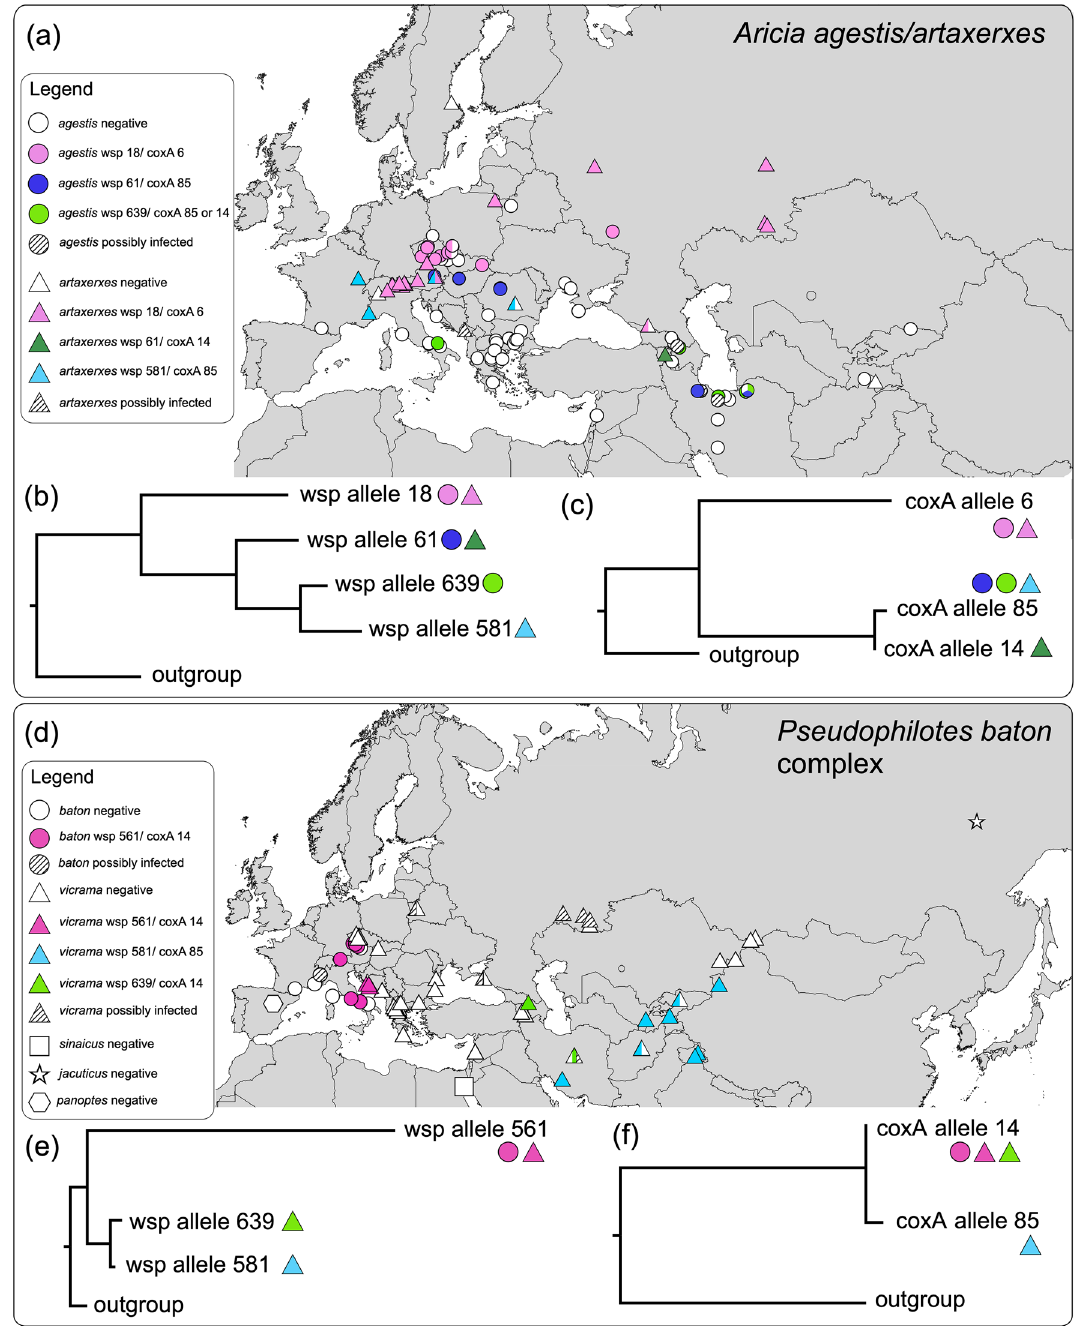
Figure 3. Wolbachia infection in two groups of closely related lycaenid butterflies: ( a – c ) Aricia agestis / A. artaxerxes : ( a ) distribution map, ( b ) Bayesian phylogenetic tree (MrBayes) of wsp, and ( c ) of coxA alleles. d–f Pseudophilotes baton species complex, ( d ) distribution map, ( e ) Bayesian phylogenetic tree of wsp, and ( f ) of coxA alleles. For a part of the samples, only the wsp gene was obtained, such samples were categorized by their wsp alleles. Maps were created in QGIS v. 2.18 (http://qgis.org) and the graphics was compiled in Graphic for Mac v. 3.1 (https ://www.graph